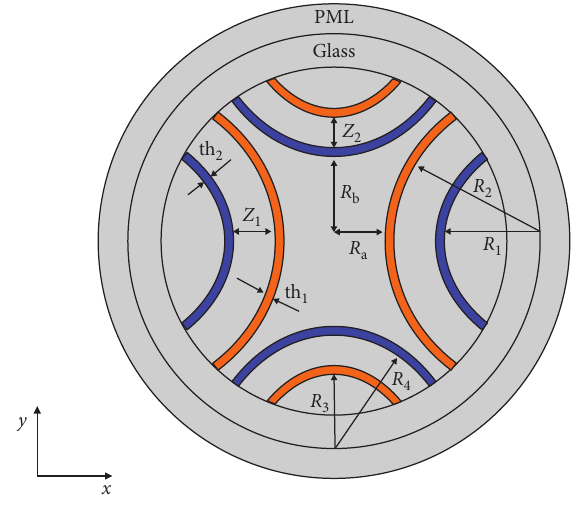
Figure 1: Structure of the proposed